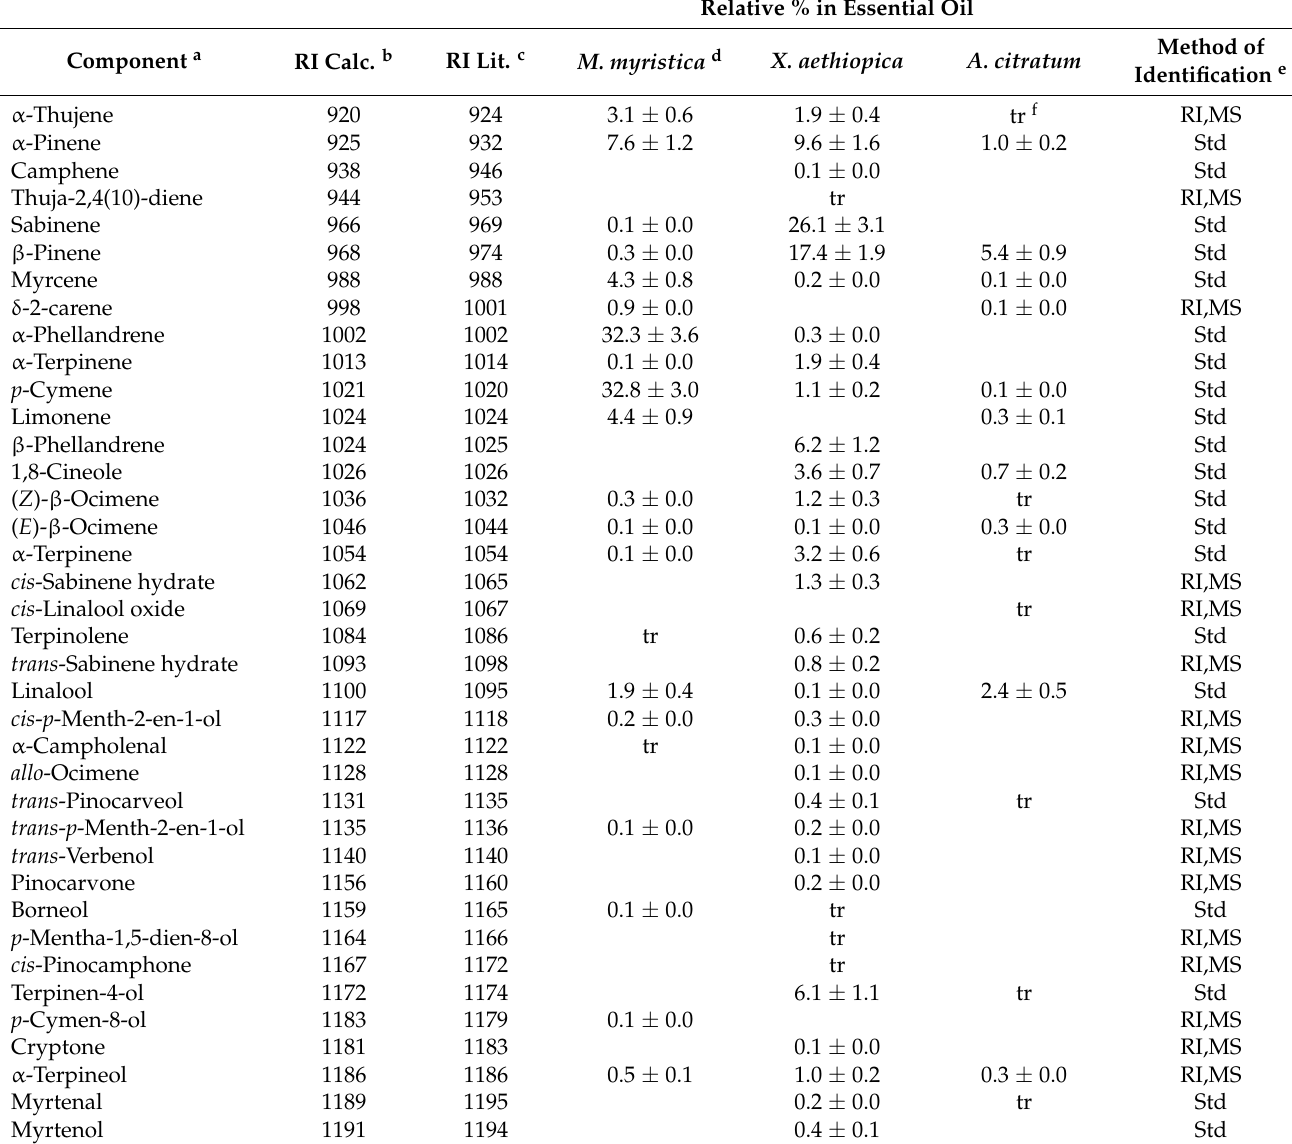
Table 1. Chemical composition of the essential oils extracted from seeds of Monodora myristica , Aframomum citratum , and Xylopia aethiopica . Relative % in Essential